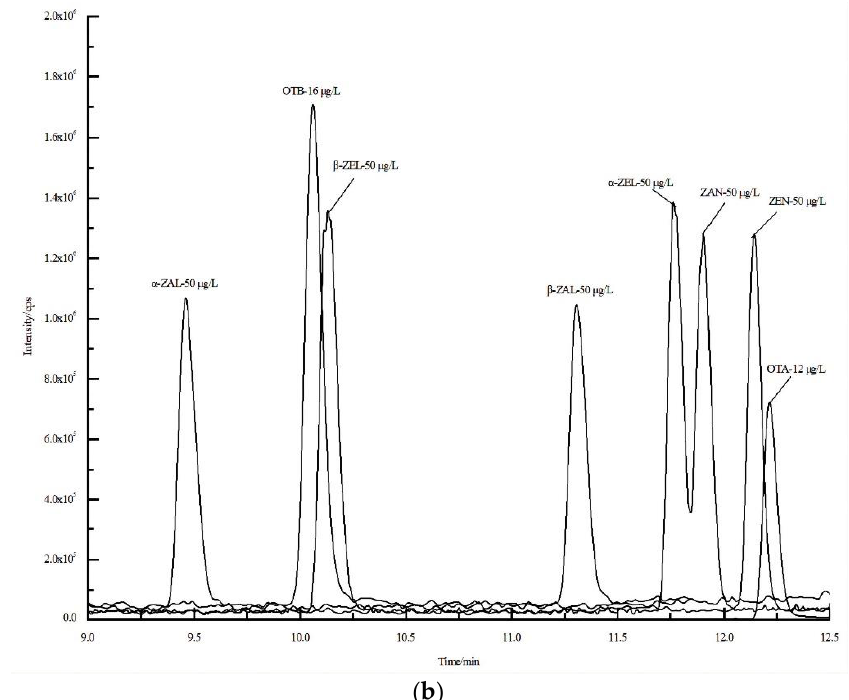
Figure 1. Extracted ion chromatograms of the 23 mycotoxins at positive mode ( a ) and negative mode ( b ).